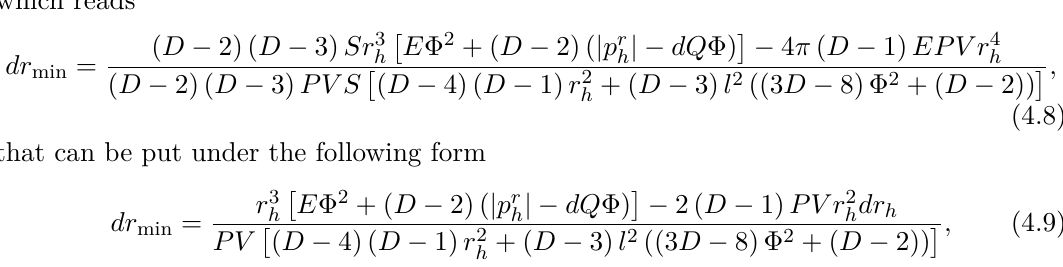
| = 0 . 1 , Q = 1 and l = 1 h